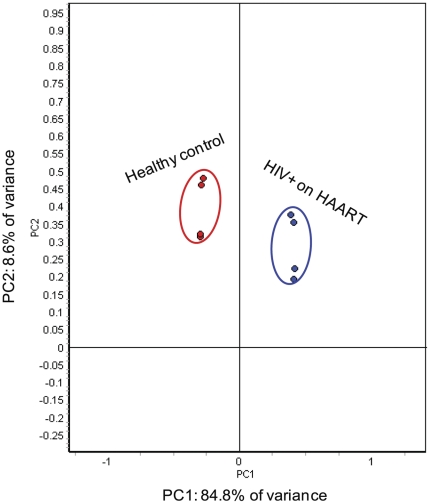
PCA of the proteins mediated by HIV and/or HAART.The protein expression profiles of experimental groups were visualized in two-dimensional Euclidian space, by using extended data analysis module of DeCyder software as described under “Materials and Methods.” The PCA distinctly clustered the 8 individual samples into two experimental groups (HIV-infected on HAART and healthy control subjects).